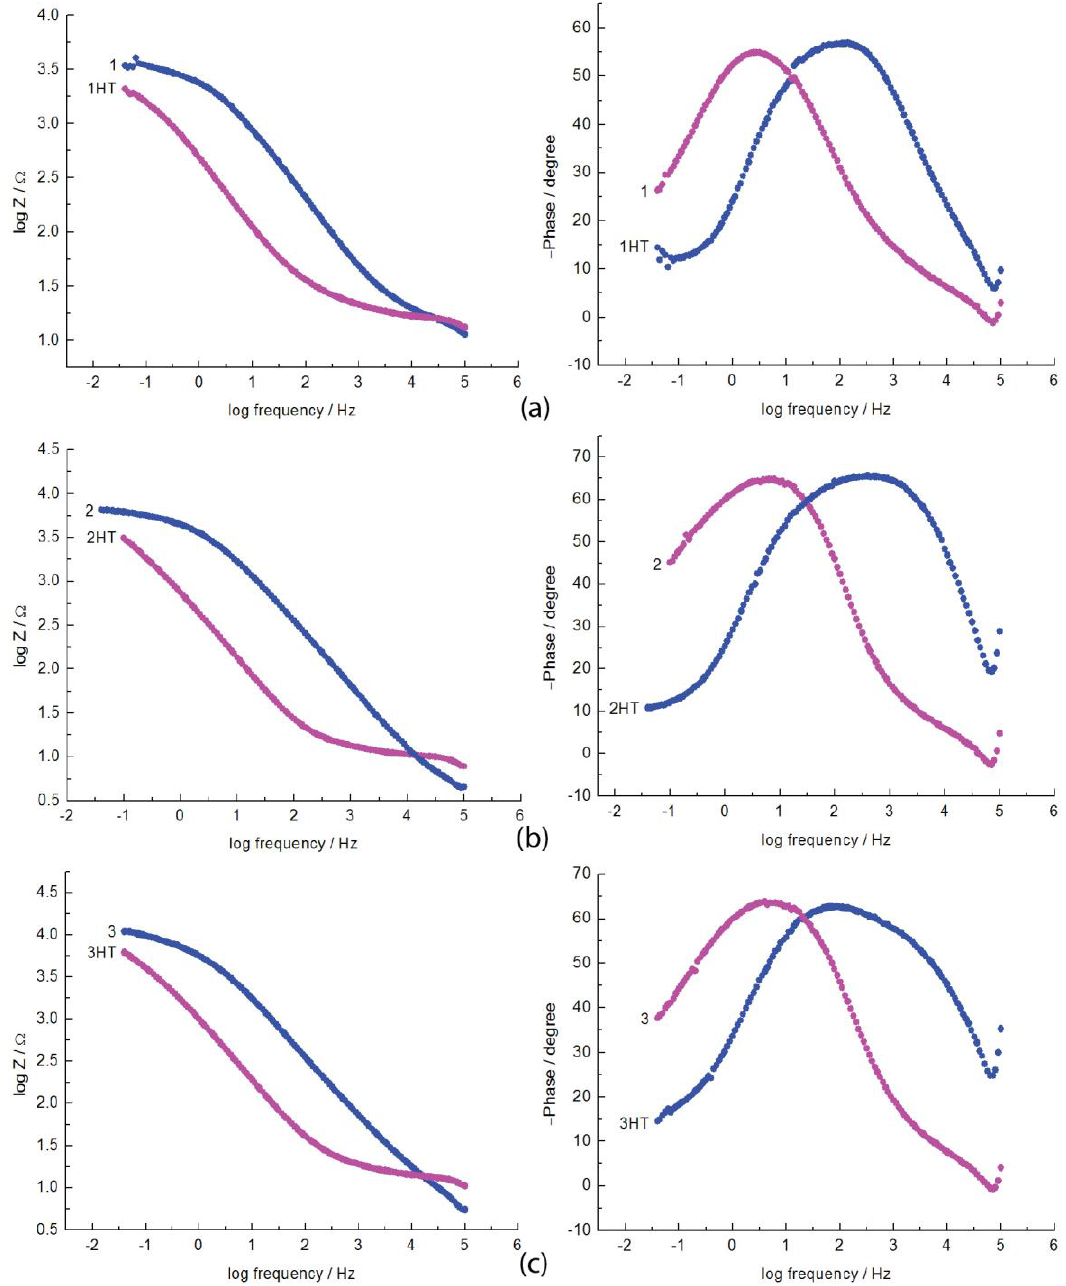
Figure 7. Bode plots for the as-deposited and heat-treated 1, 2, 3 samples of HEA thin films. ( a ) is log freq. vs. log Z and log freq. vs. – Phase, for sample 1 and 1HT, ( b ) is log freq. vs. log Z and log freq. vs. – Phase, for sample 2 and 2HT, ( c ) is log freq. vs. log Z and log freq. vs. – Phase, for sample 3 and 3HT.